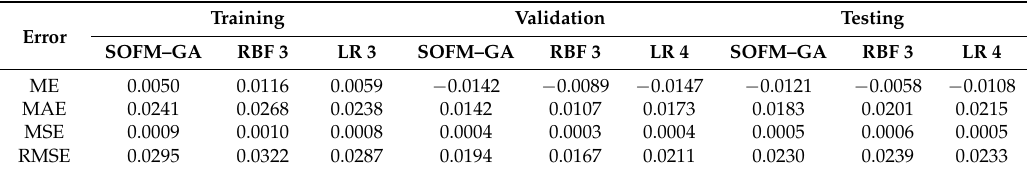
Table 14. Statistical analysis of the different models in training, validation and testing.